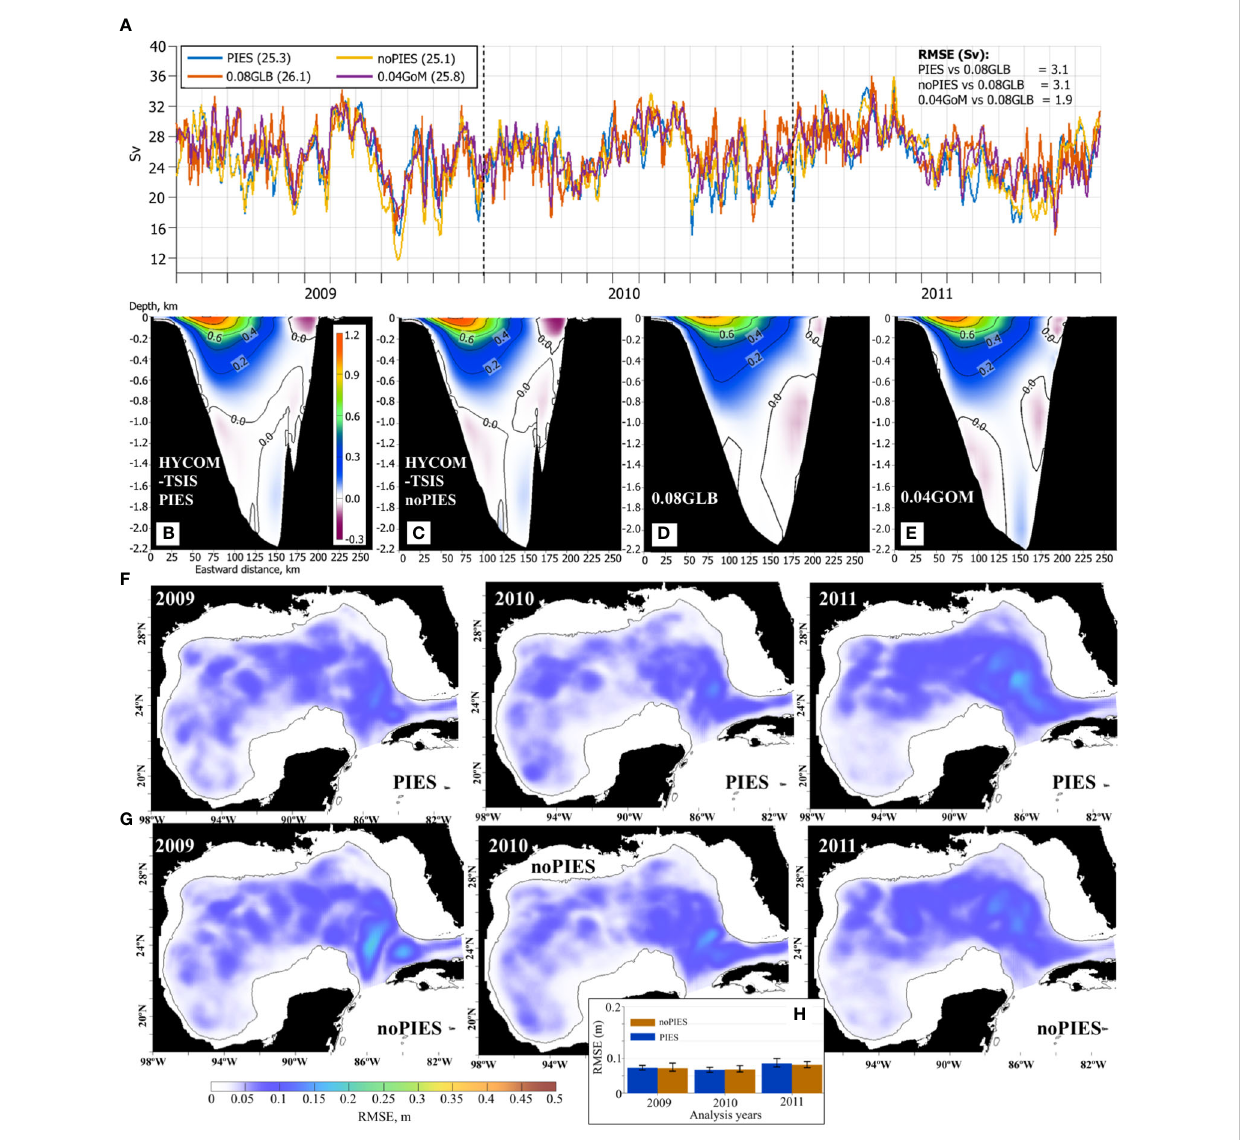
FIGURE 4 (A – E) Flow characteristics in Yucatan Channel from the 1/32.5° IAS HYCOM-TSIS OSEs, 0.08° Global HYCOM+NCODA reanalysis (0.08GLB), and 0.04° Gulf of Mexico HYCOM+NCODA reanalysis (0.04GOM). (A) Yucatan daily volume transport estimates (Sv). The mean volume transports over 2009 – 2011 are listed in parenthesis in the legend. On the right, RMSE (Sv) of the daily Yucatan transport estimates relative to the 0.08GLB is given. Vertical section of the mean along-channel velocity component (m s -1 , positive northward) in the Yucatan Channel from: (B) the 1/32.5° IAS HYCOM-TSIS OSE with PIES T/S pro fi les assimilated in the hindcast; (C) 1/32.5° IAS HYCOM-TSIS OSE without PIES T/S pro fi les; (D) 0.08GLB reanalysis; (E) 0.04GOM reanalysis. In (B – E) , the horizontal axis is the eastward distance (km) along the section (the Yucatan Shelf is on the left), the vertical axis is depth (km). (F) Annual RMSE between SSH (m) from the OSE analysis runs with assimilated PIES T/S pro fi les and from the 0.04GOM reanalysis for April 2009 – November 2011 (time interval of the PIES observations). (G) Same as (F) but OSE with no PIES T/S pro fi les. (H) Median and IQR of the RMSE from “ PIES ” and “ noPIES ” OSEs by